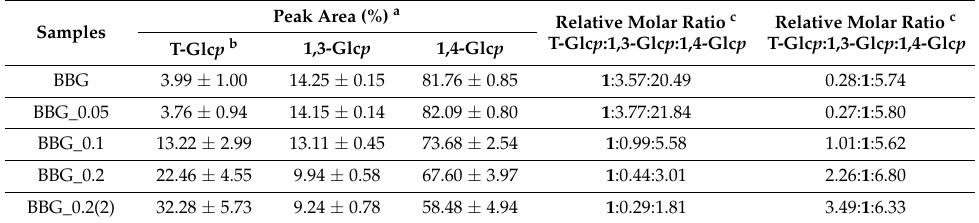
Figure 1. SEC chromatograms showing the MW distribution of BBGs and its depolymerized derivatives. Glucose was used as a monomer control. Table 2. GC-MS linkage analysis of barley β -glucan (BBG) and its acid hydrolyzed derivatives.